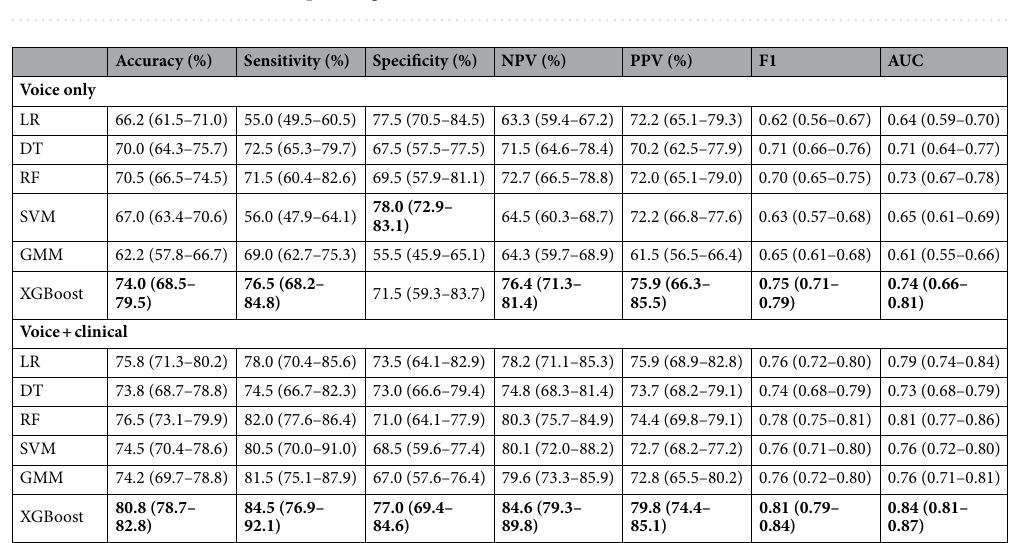
Figure 3. AUC-ROC curve of the XGBoost model for classifying tube feeding and risk of respiratory complications. AUC-ROC curves show that multimodal models that combine phonation and clinical data demonstrate high levels of AUC in classifying ( a ) risk of tube feeding and ( b ) respiratory complications. AUC area under curve, ROC receiver operating characteristic.